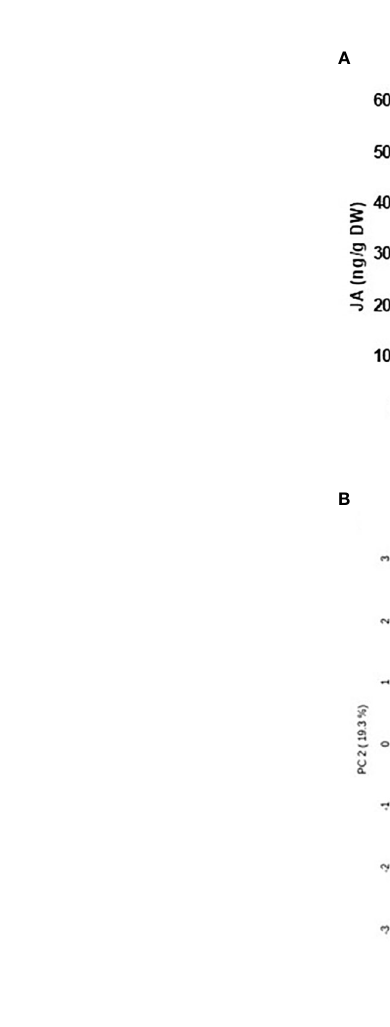
FIGURE 4 Phytohormones in bilberry (Vaccinium myrtillus) plants grown under different light regimes. (A) Accumulation of jasmonic acid (JA) in bilberry leaves grown for 14 days under 24 h (24 L) and 12 h (12 L/12 D) light regime and collected every 6 hrs, i.e. for the 12 L/12 D light regime two times each in the light and in the dark; ***: P < 0.001 (Welch-test). Phytohormone analysis was done according to Da ́ vila-Lara et al. (2021). (B) Principal component analysis of amounts of various defense – related phytohormones (JA, JA-Ile, SA, IAA, ABA) accumulating under 12 h light (L/D) and 24 h light (Light) in bilberry leaves. PC, principal component (% of total variance); con fi dence area, 95% PCA